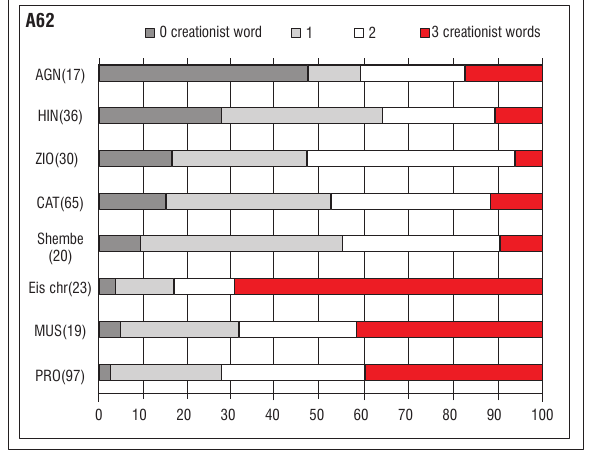
Figure 5: Percentage of teachers (grouped by religious affiliation) who selected 0, 1, 2 or 3 creationist words in Question A62 on the origin of